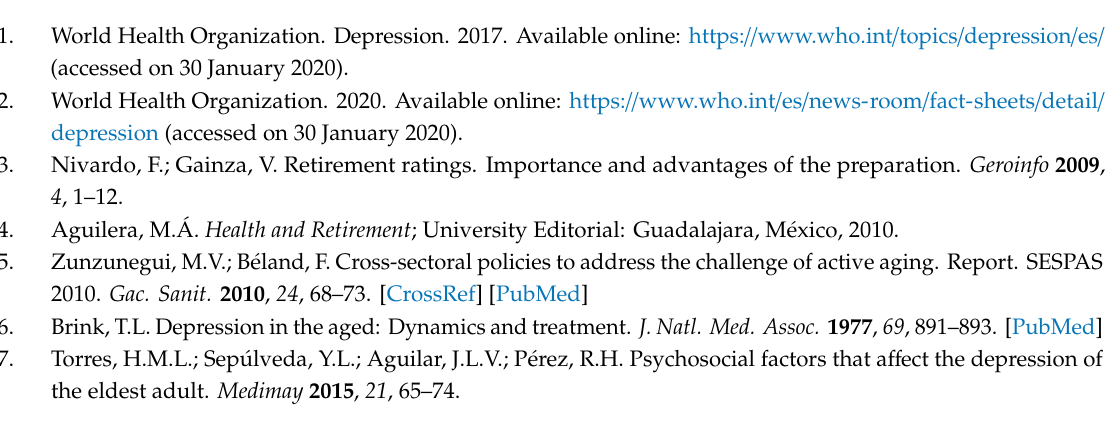
Table S1: Articles selected in the systematic